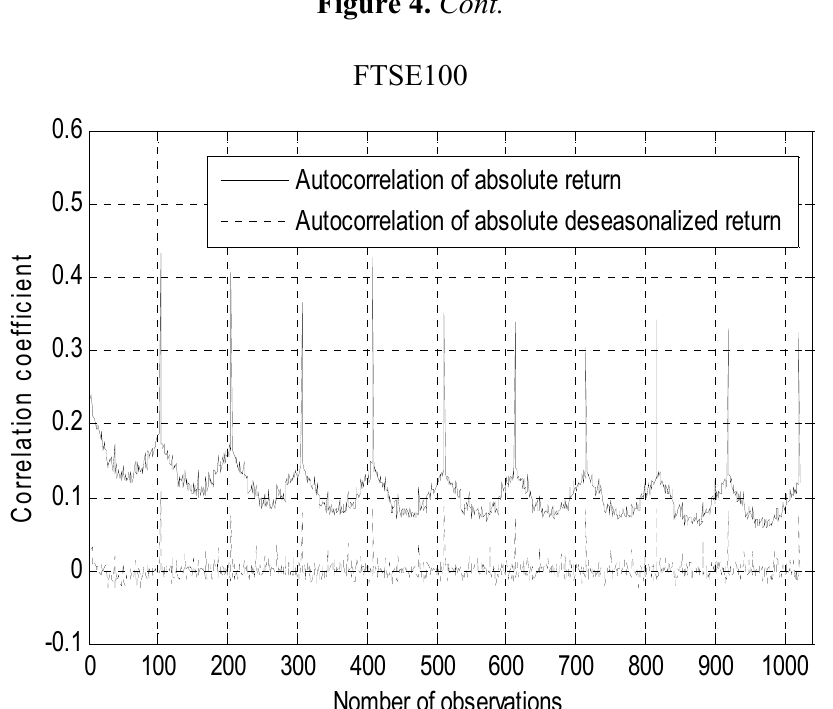
Figure 4. Cont. FTSE100